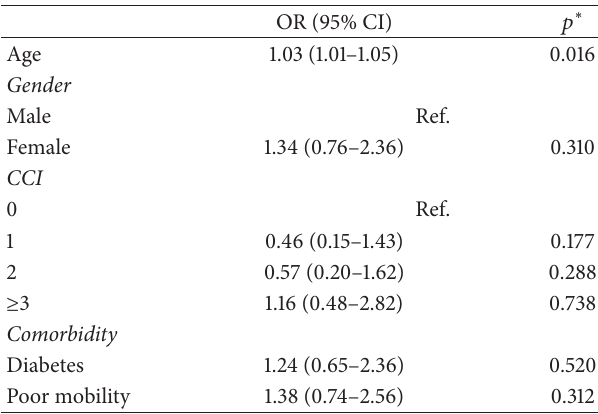
Table 2: Multivariable analysis predicting poor bowel